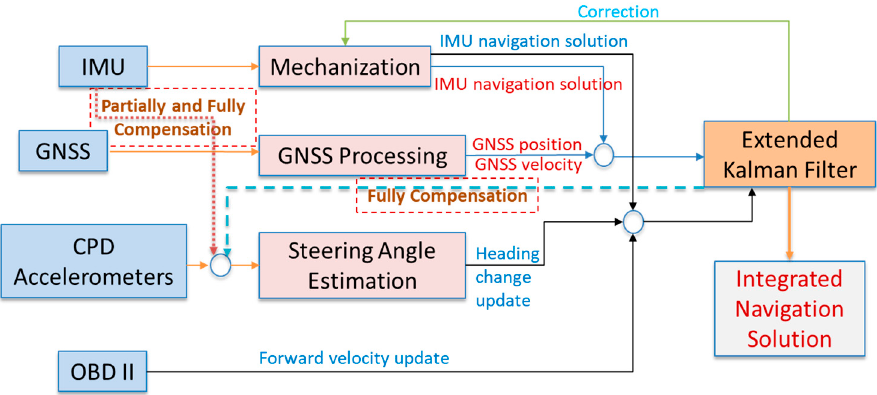
Figure 8. Navigation system with different compensation for the steering angle estimation method.